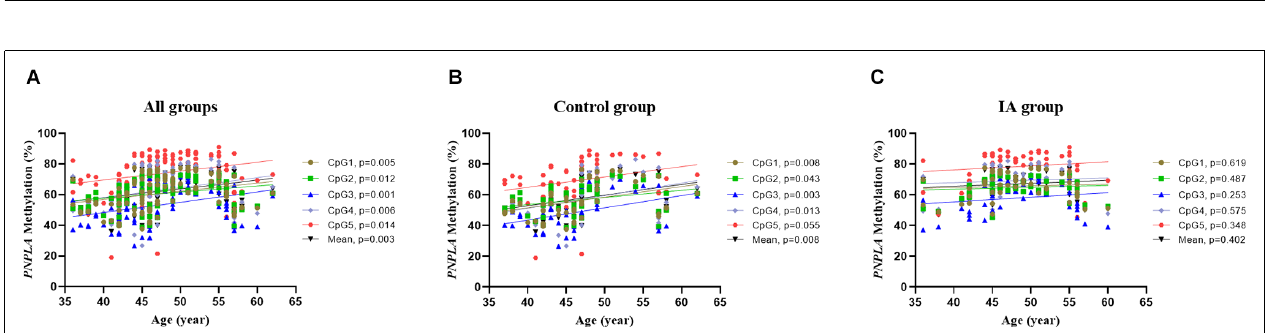
FIGURE 3 | Comparison of the five GpGs methylation levels in different subgroups. (A) The comparison between controls and IAs in males and females. (B) The comparison between controls and IAs in males. (C) The comparison between controls and IAs in females. (D) The comparison between males and females in the control group. (E) The comparison between males and females in the IA group. (F) The comparison between ruptured IA and unruptured IA. Data were represented as mean ± SD.